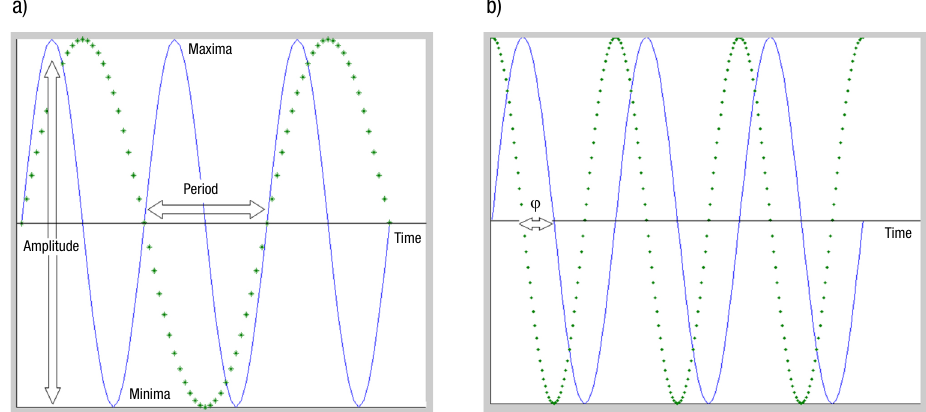
Fig. 1. Principle of Complex Period Test – checking all periods and phase angles, source: own